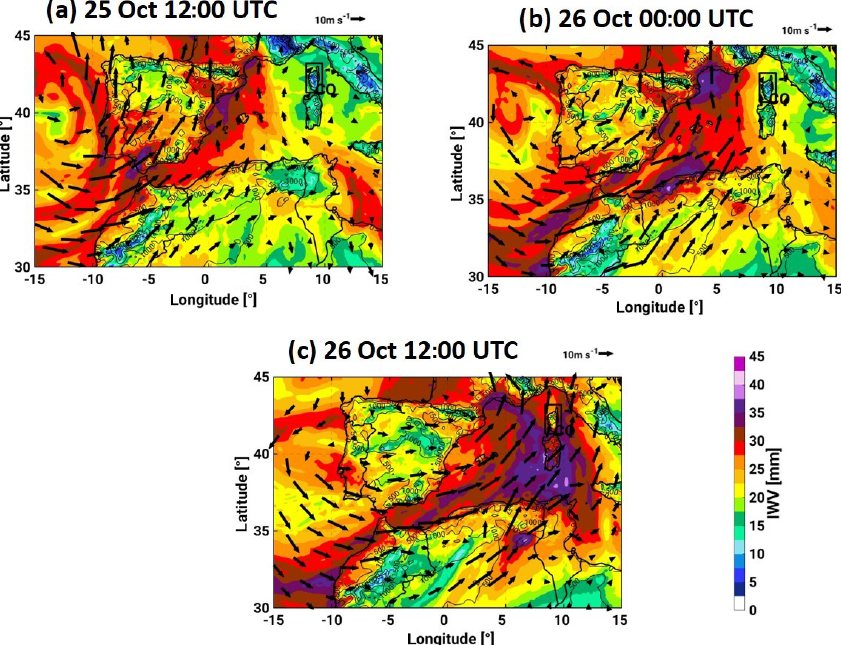
Figure 4. Spatial distribution of IWV and winds at 850hPa as represented by CTRL-7 on 25 October 2012 at 12:00UTC (a) , on 26 October at 00:00UTC (b) and on 26 October 2012 at 12:00UTC (c)